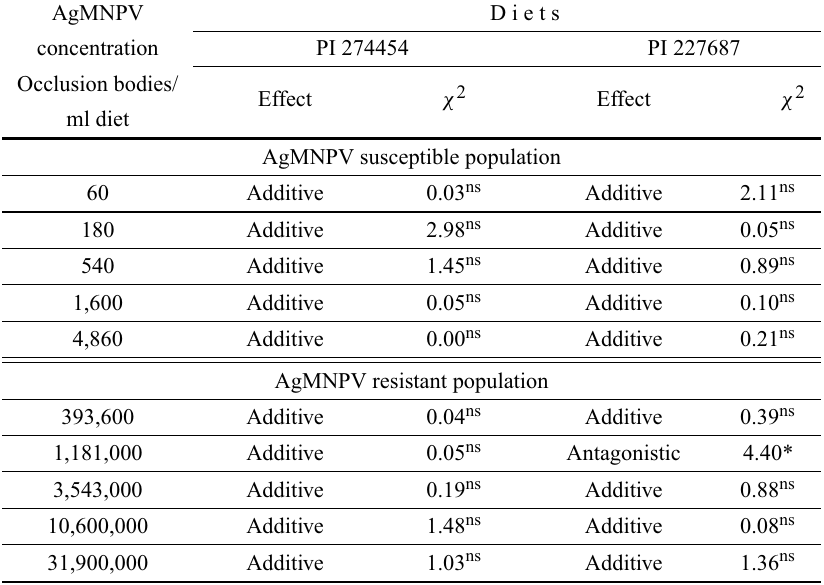
Interactions 1 among (between) soybean extracts (PI 274454 and PI 227687) and six concentrations of the AgMNPV in susceptible and resistant populations to the virus.